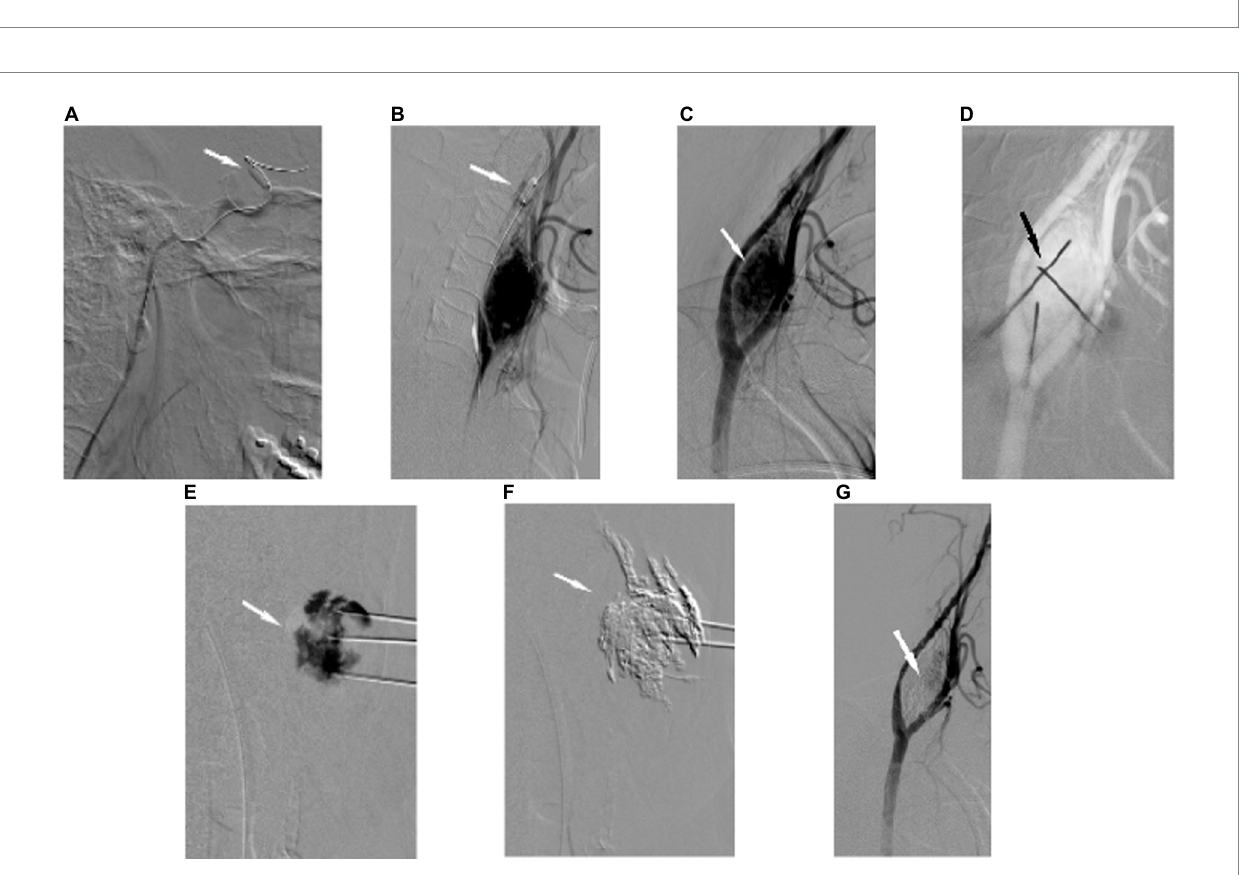
FIGURE 2 DSA of the left ICA with the (A) first balloon occlusion test (BOT): balloon occlusion of the supraophthalmic segment of the left ICA. (B) Second BOT: balloon occlusion of the cervical segment of the left ICA. (C) Carotid body tumor on the left side, DSA of the left common carotid artery (CCA); sagittal view. (D) Control of the positions of 3 percutaneously inducted Chiba needles into the tumor mass. (E) Parenchymogram of the CBT on the left side. (F) Fluoroscopic control of percutaneous injection of Onyx 18 into CBT through Chiba needles. (G) DSA of the left CCA after percutaneous injection of Onyx into the CBT mass with devascularization of the